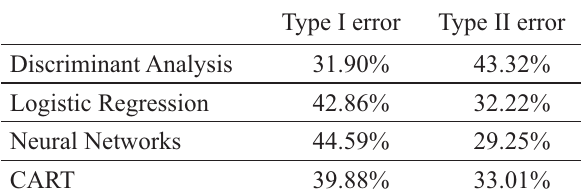
Table 6. Type I and Type II errors of four